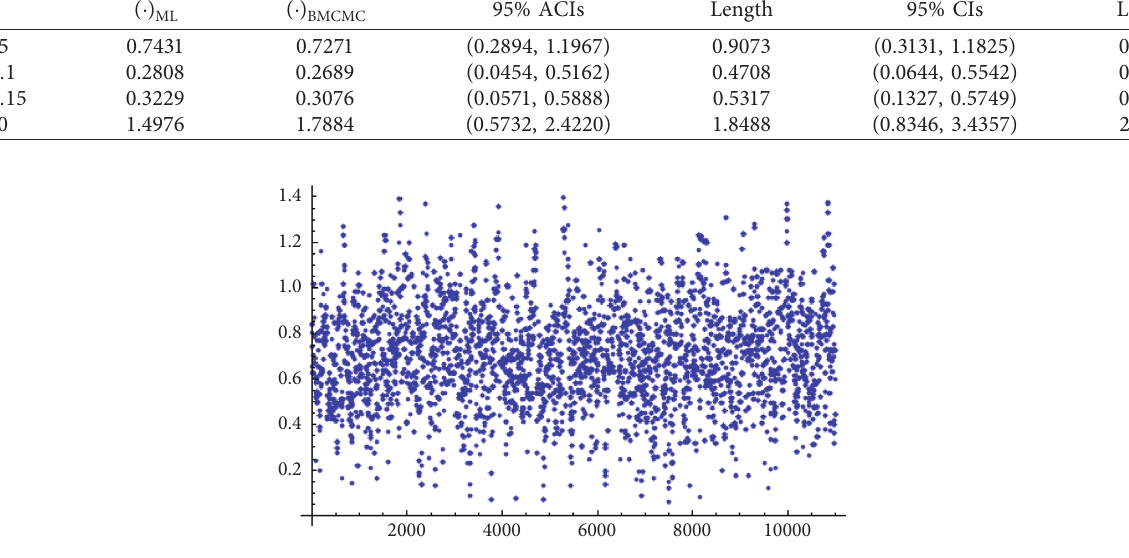
Table 5: Point and 95% confidence and credible intervals (ACIs and CIs) of MLE Bayes estimates. Pa.s